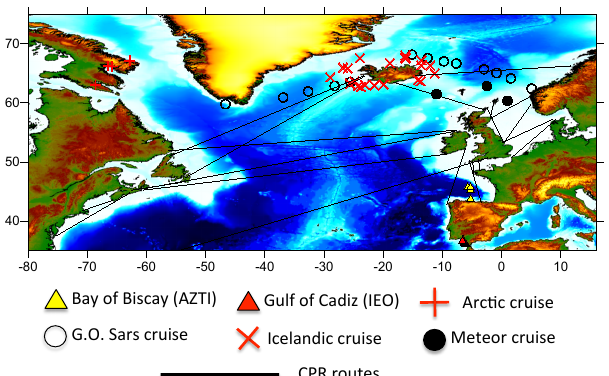
Figure 1. Sampling sites and CPR routes along which jellyfish data were